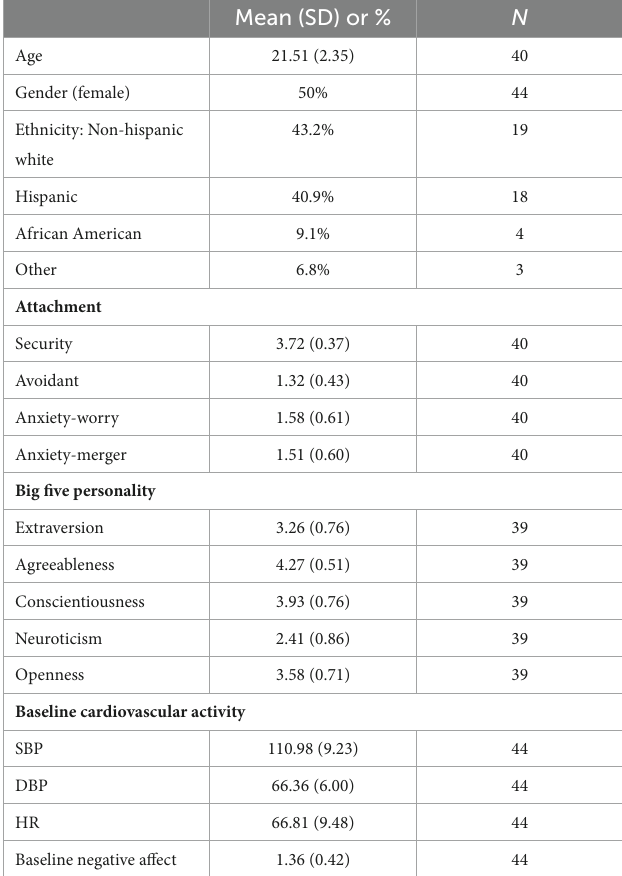
TABLE 1 Sample characteristics and descriptive statistics for study